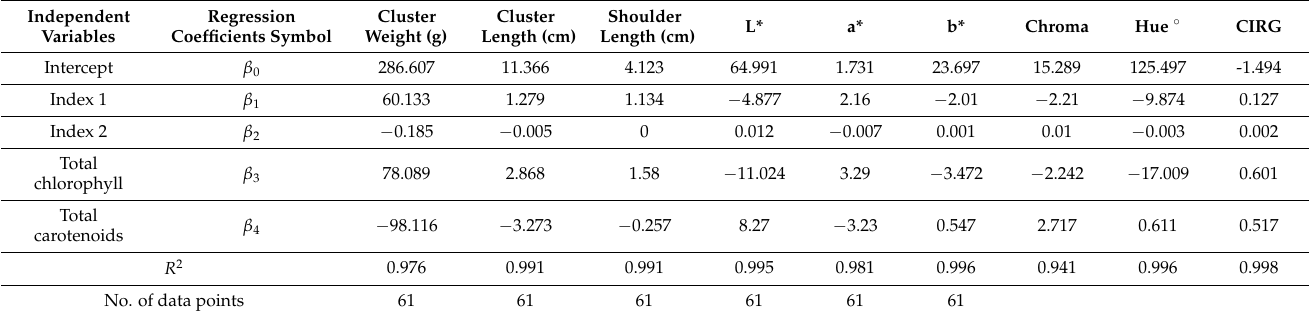
Table 8. Coefficients of determination ( R 2 ) and regression coefficients values of regression equation (Equation (9)) for modeling cluster weight, cluster length, cluster shoulder length, berries L*, a*, b*, C, h, and CIRG of Flame Seedless